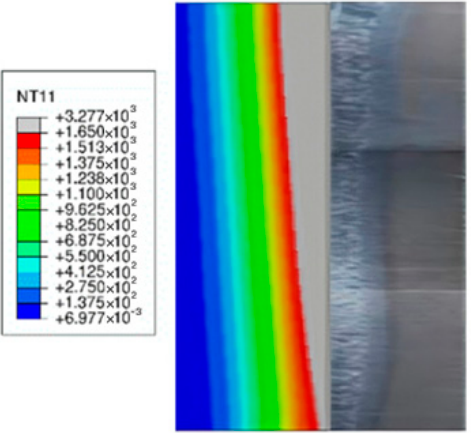
Figure 7. Shape of the weld pool compared to the experimental result.